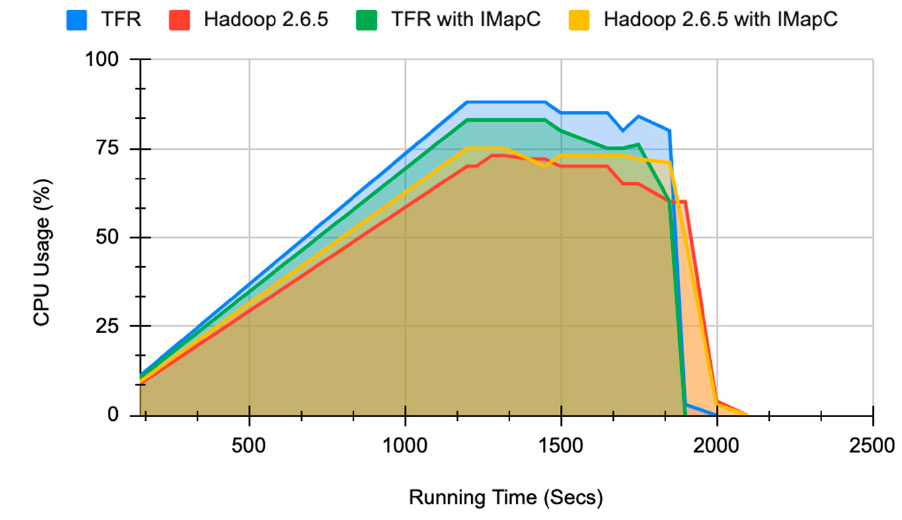
Figure 10. CPU resource usage on running WordCount job for 35 GB dataset.